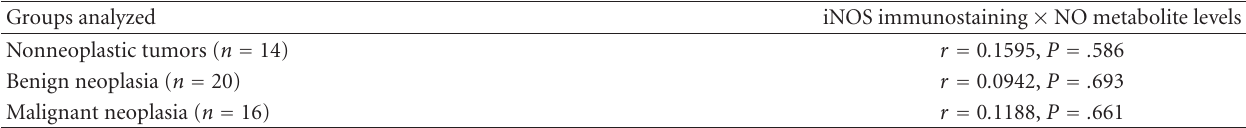
Table 3: Correlation between iNOS immunostaining and NO metabolite levels detected in tissue samples collected using Spearman’s rank correlation coe ffi